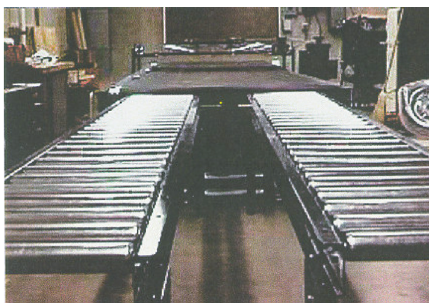
Figure 3: Front view of grass-feeding